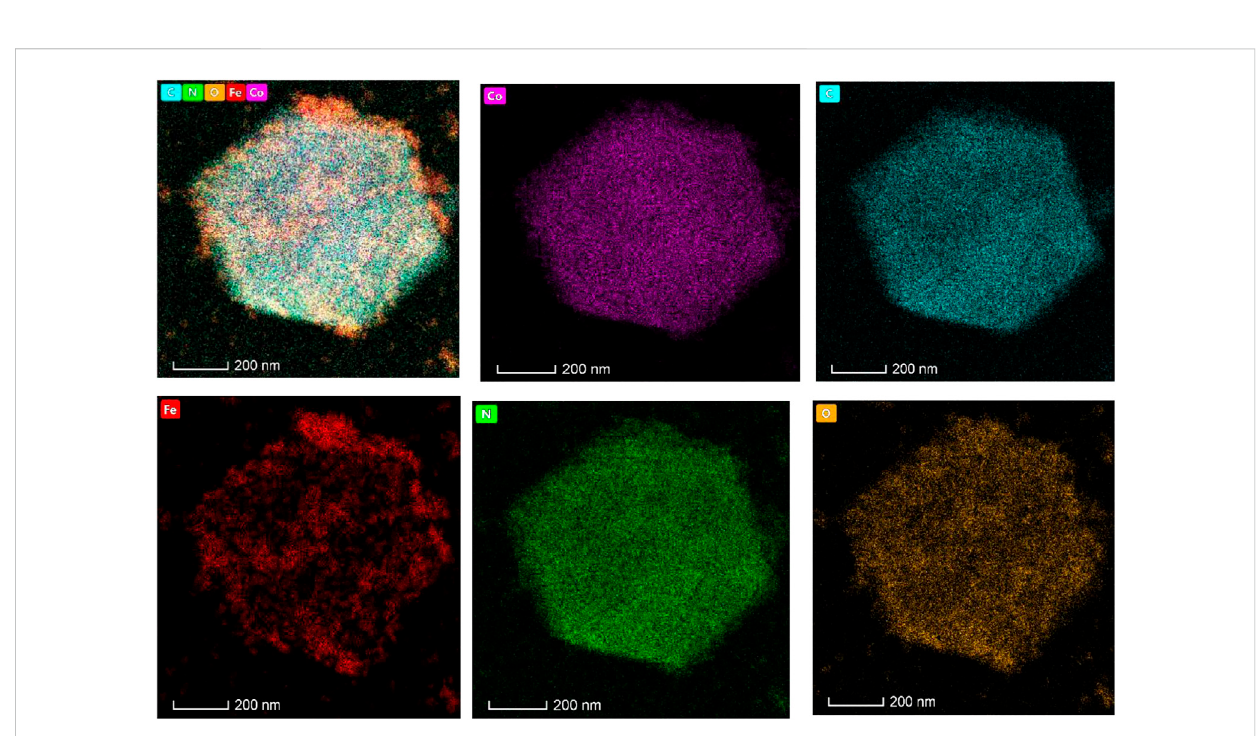
FIGURE 5 The element distribution mapping of Fe 3 O 4